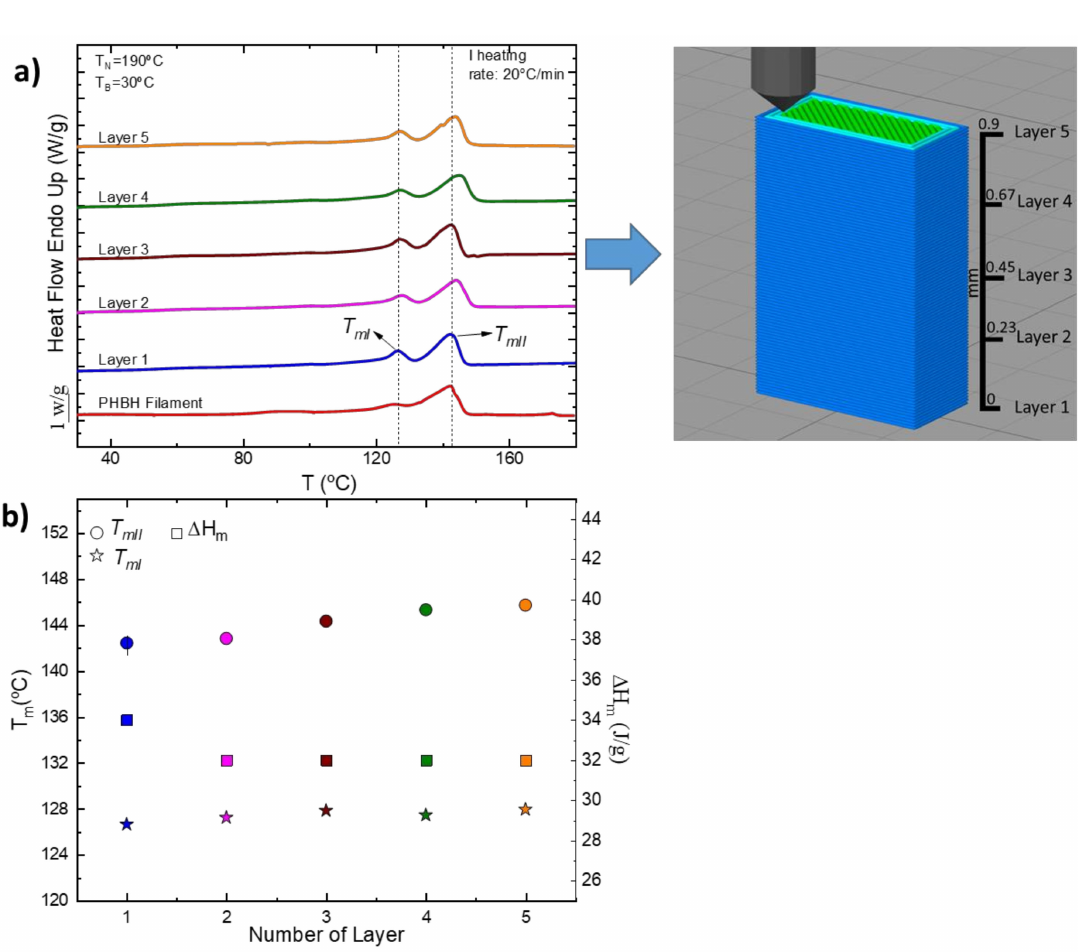
Figure 3. ( a ) First heating DSC scans of different layers of the PHBH tower and ( b ) melting tempera- tures as a function of the number of